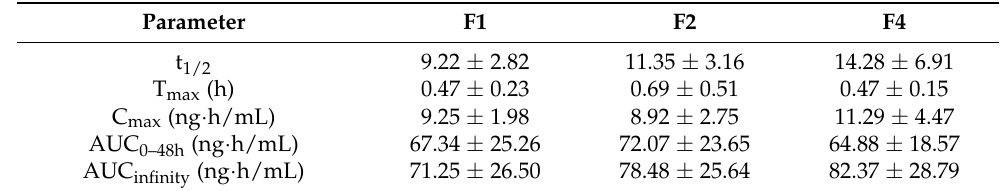
Table 6. Pharmacokinetic parameters of JIN-001 following single oral administration of F1, F2 and F4 formulations (20 mg) to beagle dogs ( n =